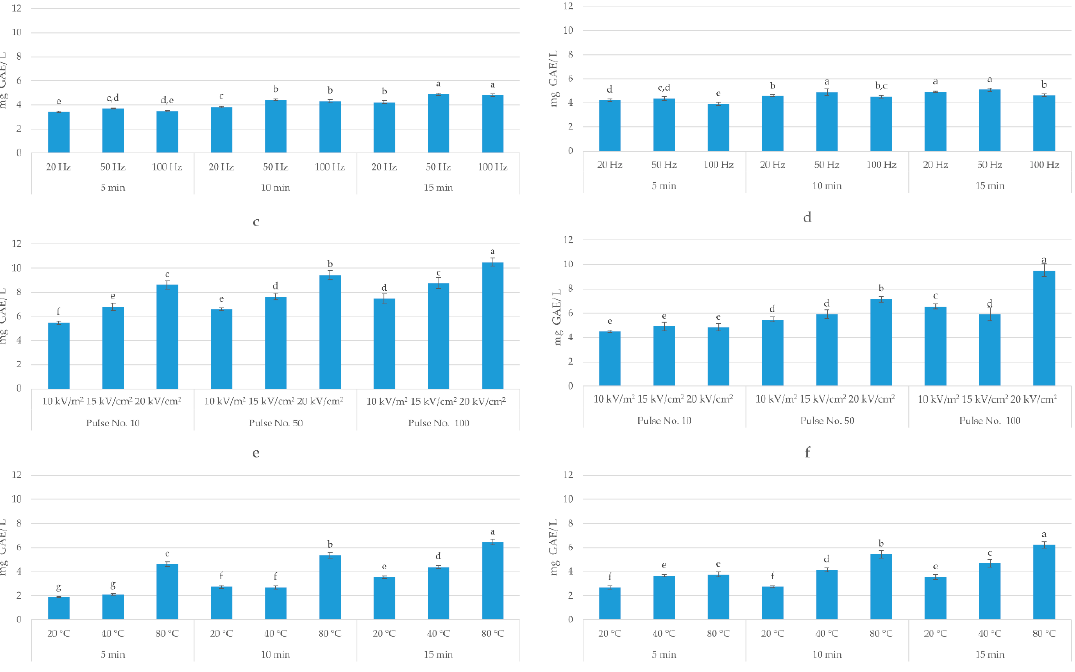
Figure 3. Total polyphenol content (mg GAE / g dw) of: ( a ) high voltage electrical discharges (HVED) ethanol-based extracts; ( b ) HVED methanol-based extracts; ( c ) pulsed electric field (PEF) ethanol-based extracts; ( d ) PEF methanol-based extracts; ( e ) ultrasound-assisted extraction (UAE) ethanol-based extracts; ( f ) UAE methanol-based extracts. Bars with different letters are significantly different ( p < 0.05).